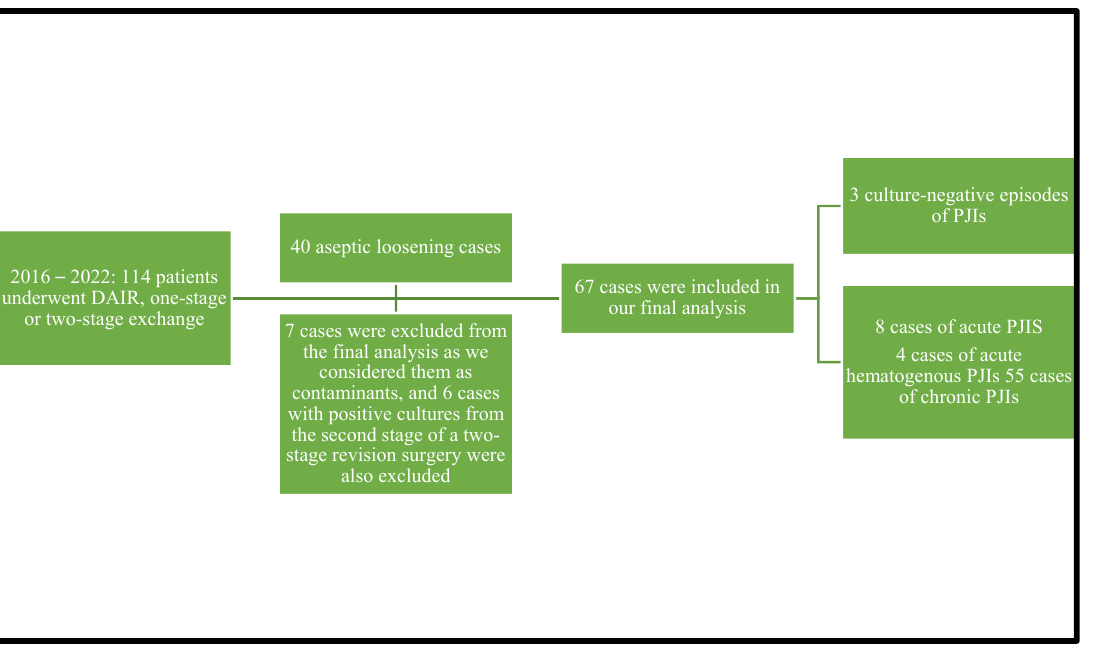
Figure 1. Flow diagram showing details of the enrolled patients. Table 2. Baseline characteristics of the enrolled patients diagnosed with PJI from 2016 through